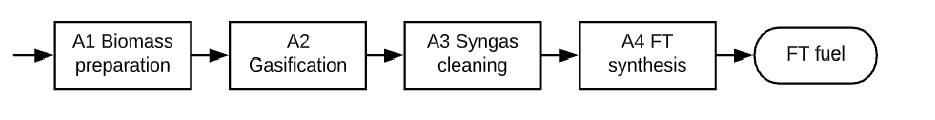
Fig. 1. FT fuel production